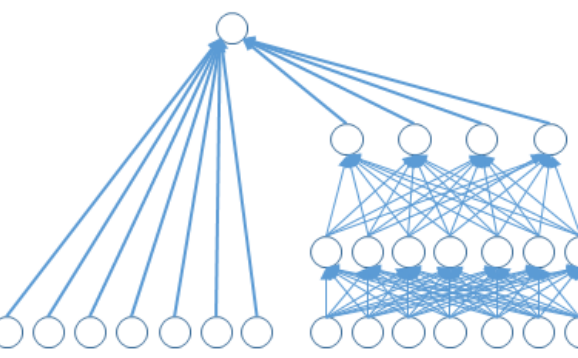
Figure 5. An illustration of DWNN.